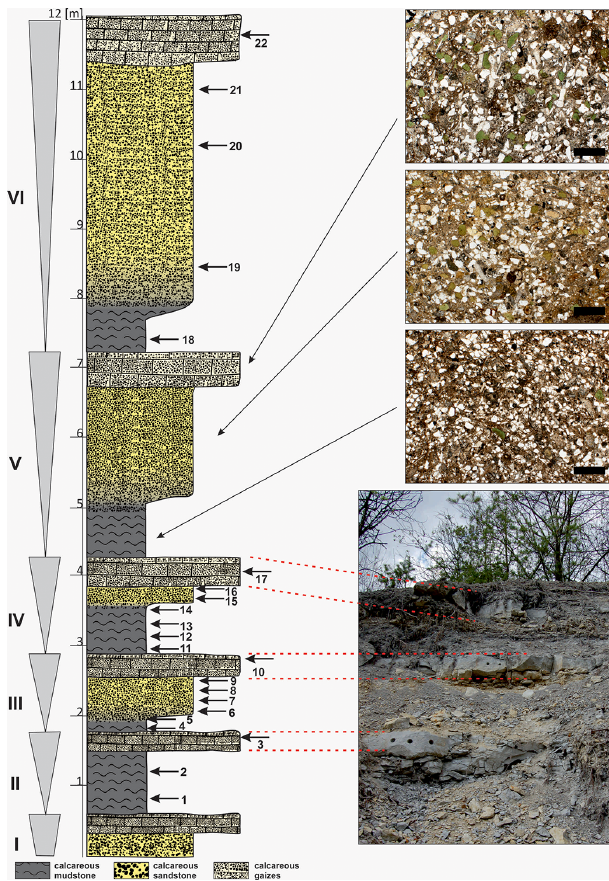
Figure 5. Lithological column of the Szozdy section. Triangles on the left side of the column indicate coarsening-upward cyclothems. Top right: typical thin sections from successive lithofacies of a sin- gle cyclothem; scale bar = 500µm; most of the white particles rep- resent quartz grains. Bottom right: field photo of a part of the se- cession with prominent layers of calcareous gaize, indicated on the section by red dashed lines. The horizontal scale represents relative resistance to weathering of particular units.